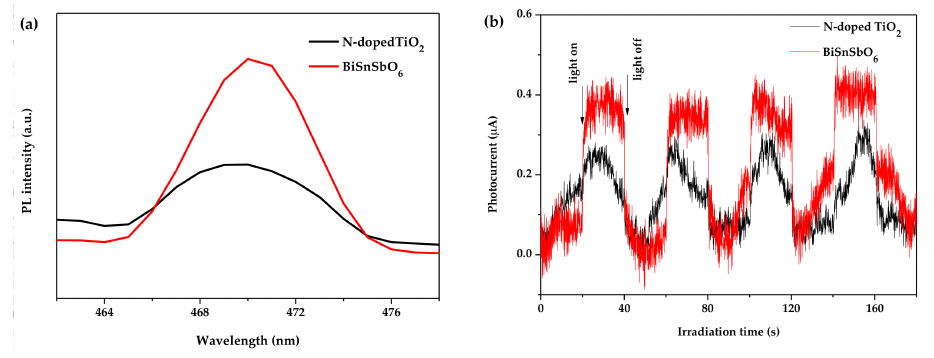
Figure 10. ( a ) The photoluminescence spectra (PL) and ( b ) transient photocurrent response of BiSnSbO 6 and N-doped TiO 2 .